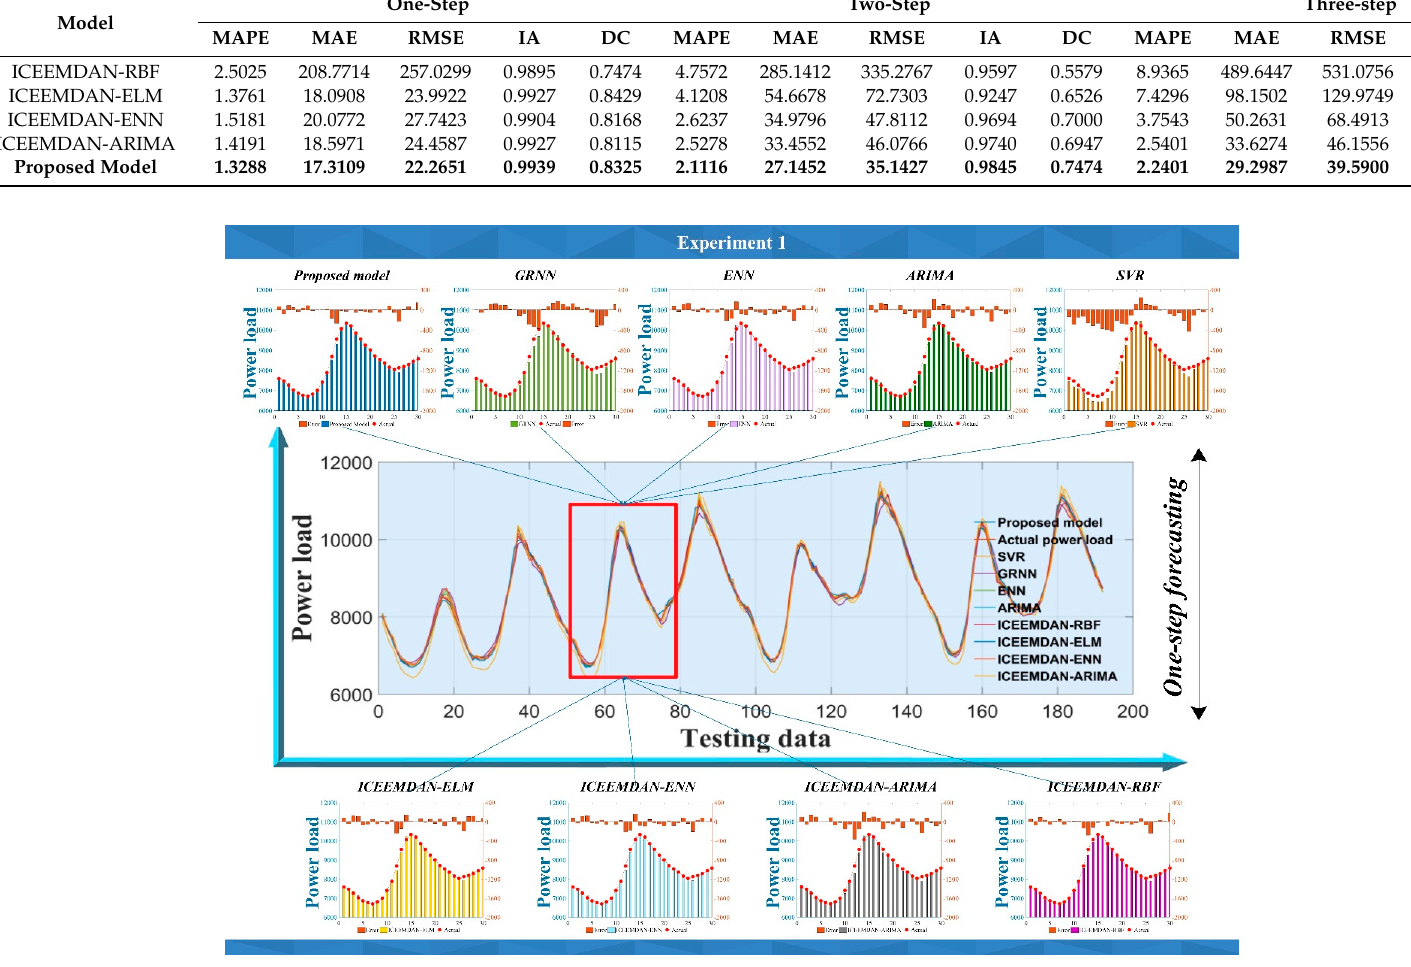
Figure 4. The multi-step prediction ability of all models in Experiment I for site 1. The center of the picture is a one-step prediction time series figure. Around it are the error diagrams of eight comparison models and the proposed